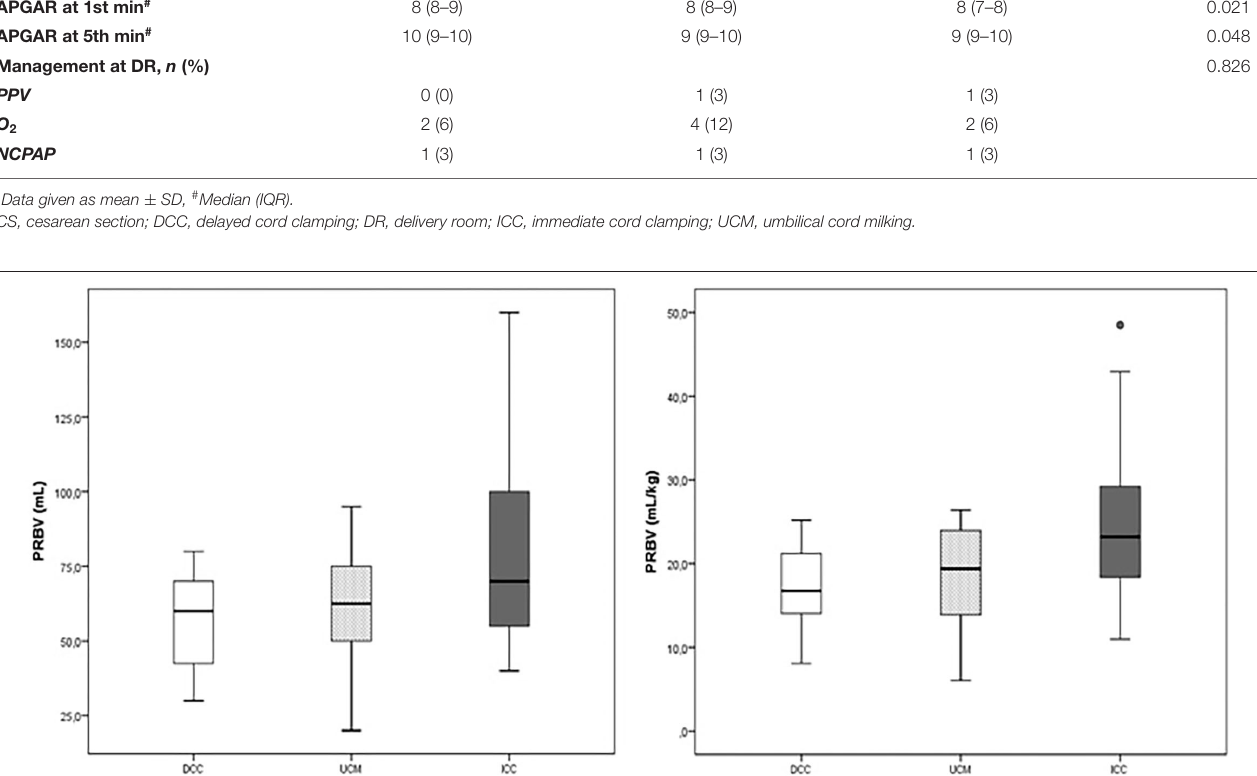
in the UCM group than in the DCC group at the 10th min ( p < 0.001) ( Figure 3